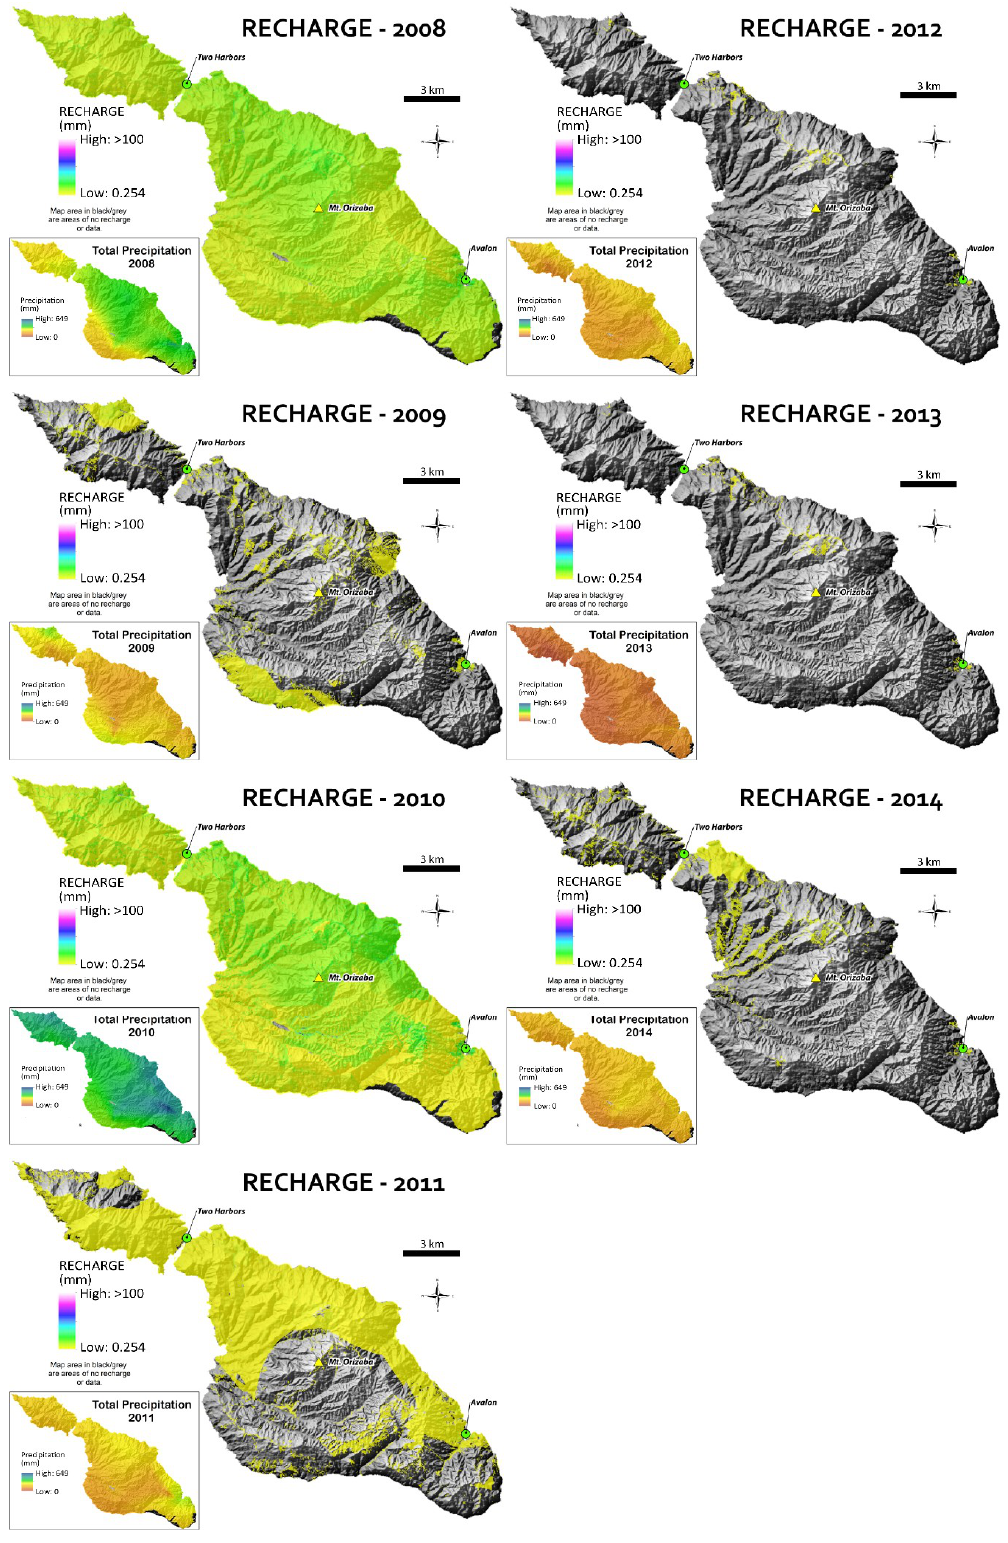
Figure 7. Year-by-year recharge distribution maps. Insets show yearly gross precipitation.